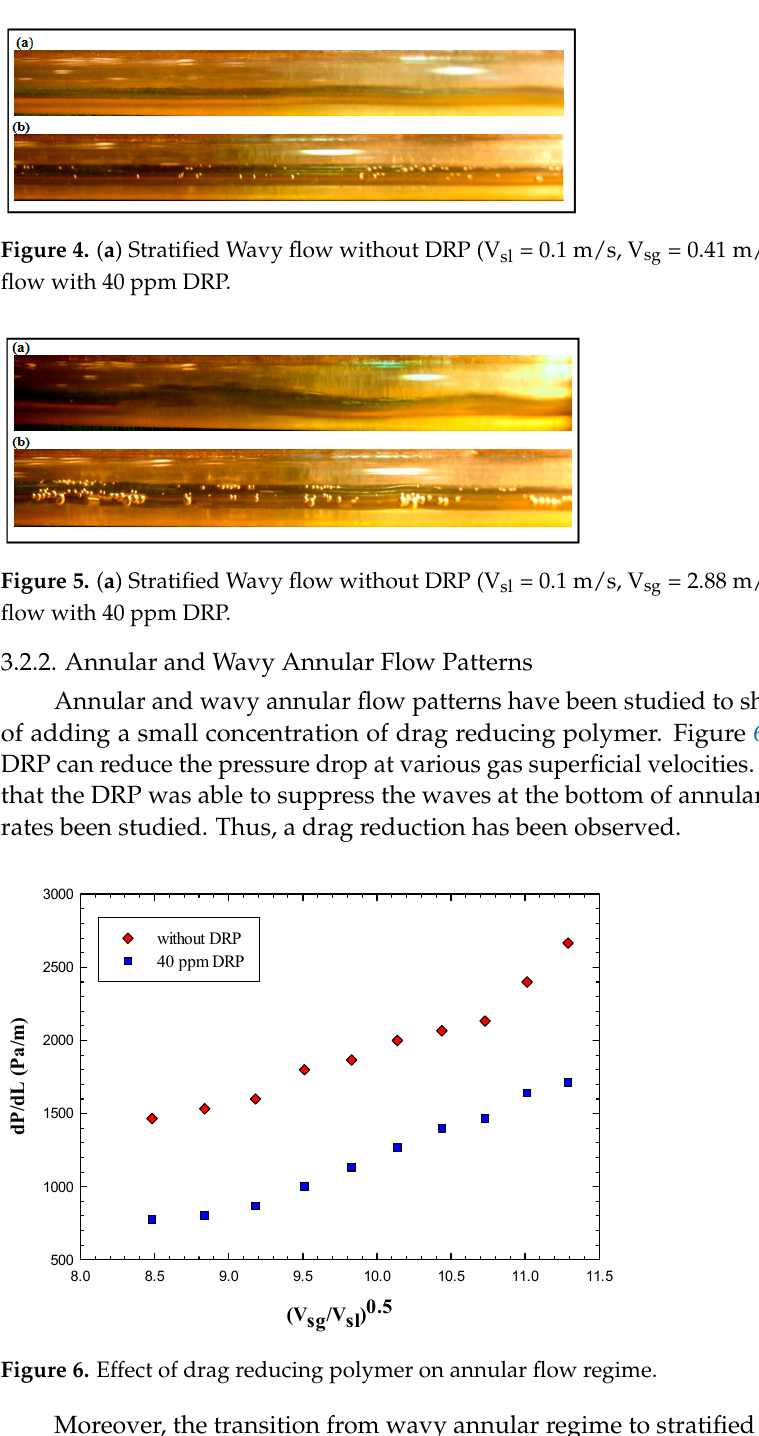
Figure 7. ( a ) Annular flow regime without DRP (V sl =0.1 m/s, V sg = 9.05 m/s); ( b ) Annular flow regime with 40 ppm of DRP. Figure 8. Annular wavy flow regime (V sl =0.1 m/s , V sg = 12.75 m/s). The effectiveness of the drag reducing polymers is very sensitive to the way that the DRP been introduced to the system (Al-Sarkhi et al. [3]), in the present study a diaphragm pump has been utilized to inject the polymer into liquid film of the annular flow to avoid polymer molecules breakup. Figures 7 and 8 indicated that the wavy annular flow shifted slightly to stratified wavy regime as DRP injected. It should be noted that drag reducing polymers acting to stabilize the liquid film by damping disturbance waves at the gas liquid interface, thus a reduction in pressure drop occurs and also an increase in the mean liquid thickness could be observed, this realization in a good agreement with Spedding et al. [13] and Thwaites et al. [14] findings for the annular flow regime. 3.2.3. Dispersed Bubbly Flow Regime As the liquid superficial velocity further increases the dispersed bubbly regime would be a possible candidate and generally this flow pattern characterized by small bub- bles introduced as a discrete particle in the liquid continuous phase. Figure 9a shows the typical behavior of the bubbly flow. The performance of the DRP has been examined for this type of flow; Figure 10 exhibits the variation of the pressure drop with the dimension- less superficial velocity with and without the DRP. The results are reported in Appendix B, it can be seen that the maximum drag reduction percentage occurred was about 55%